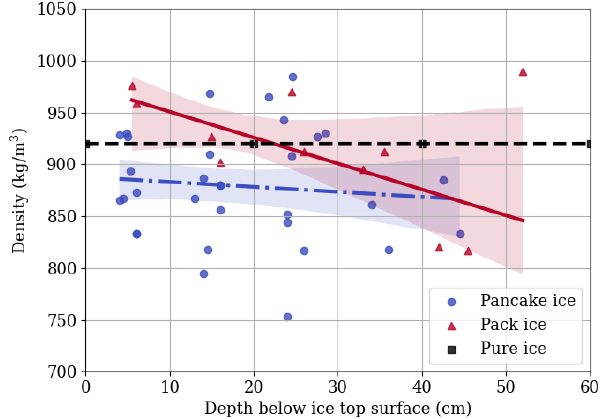
Figure 9. Bulk density as a function of depth for pancake ice floes and consolidated pack ice at stations MIZ1D (cores M01-US-01- A, M01-US-01-B, M01-US-01-C, M01-US-01-D, M01-US-02-A, M01-US-02-B, M01-US-02-C, M01-US-02-D) and MIZ3A (cores M03-US-01-A and M03-US-02-A), respectively. The shading indi- cates the 90th-percentile confidence